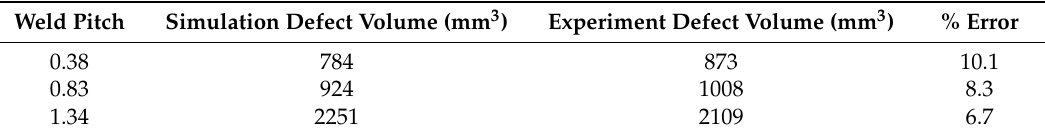
Table 8. Defect volume comparison between simulation and experiment.